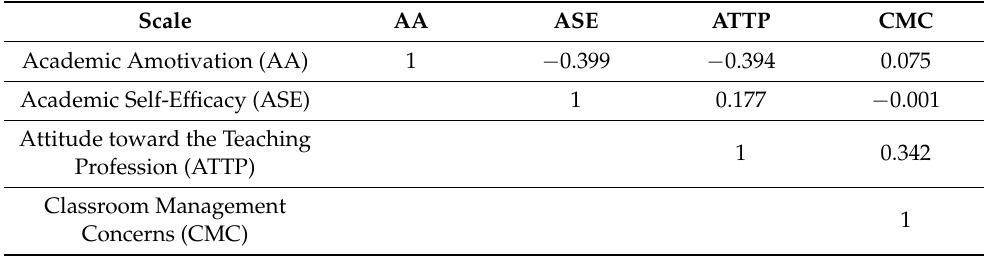
Table 2. Correlation values between